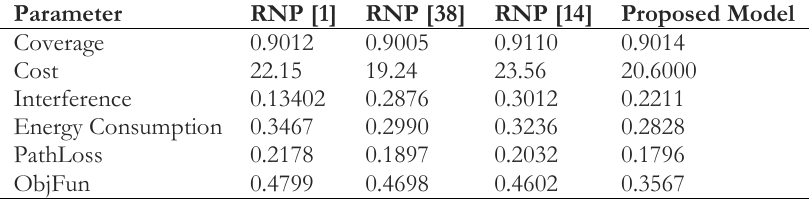
Table 16. Comparison of the proposed RNP model against the existing RNP models, for scenario